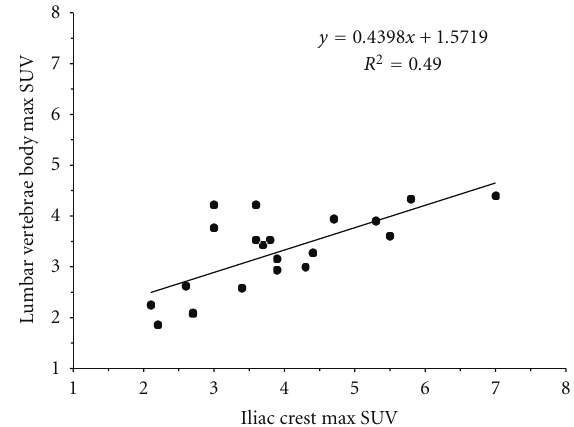
Figure 5: Lack of correlation between late follow-up platelets count (day 100) and maximal SUVs in lumbar vertebrae; the metabolic activity in the remote BM did not predict the late hematopoietic